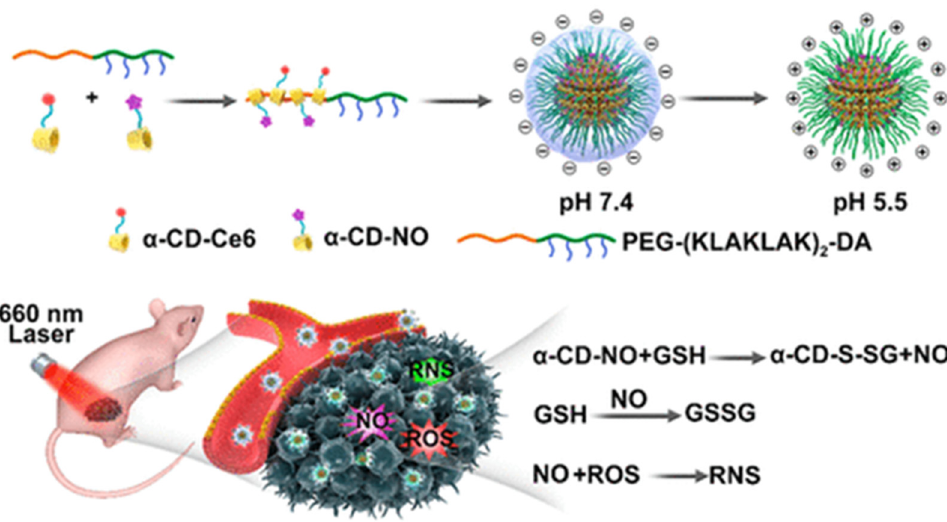
Figure 6. A surface charge switchable supramolecular nanocarrier (reproduced with permission of American Chemical Society from ref. [55]). American Chemical Society from ref.